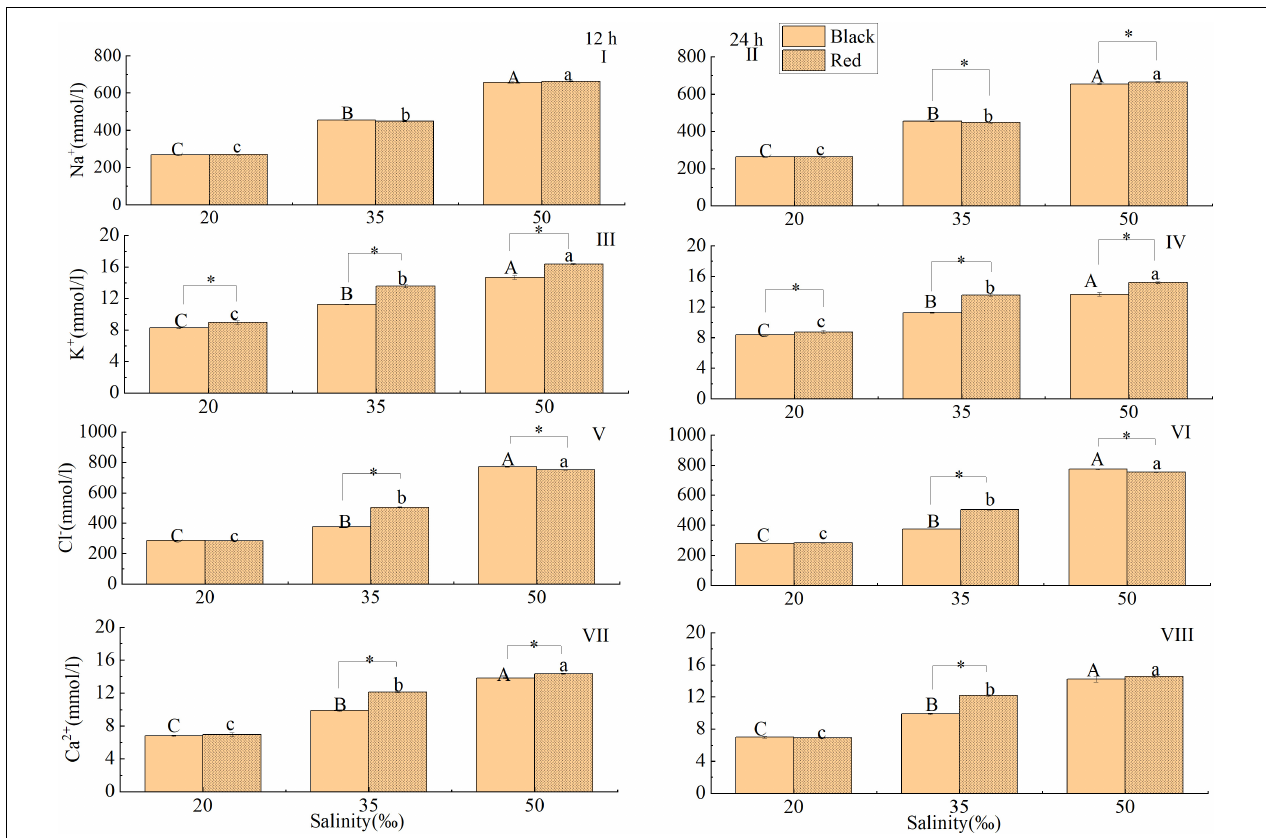
FIGURE 3 | Effect of salinity on inorganic ion concentration in the hemolymph of P. fucata with two shell colors (I: 12h, Na + concentration; II: 24h, Na + concentration; III: 12h, K + concentration; IV: 24h, K + concentration; V: 12h, Cl − concentration; VI: 24h, Cl − concentration; VII: 12h, Ca2 + concentration; VIII: 24 h, Ca2 +